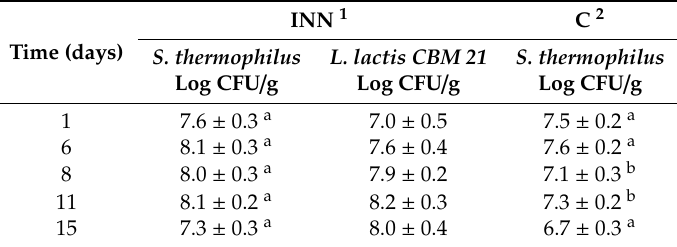
Table 2. Cell load (Log CFU / g) of Streptococcus thermophilus and Lactococcus lactis CBM 21 in innovative (INN) and traditional (C) Squacquerone cheeses during refrigerated storage. At the same time of storage, the means ± SD of S. thermophilus followed by di ff erent superscript letters ( a or b ) are significantly di ff erent, p <